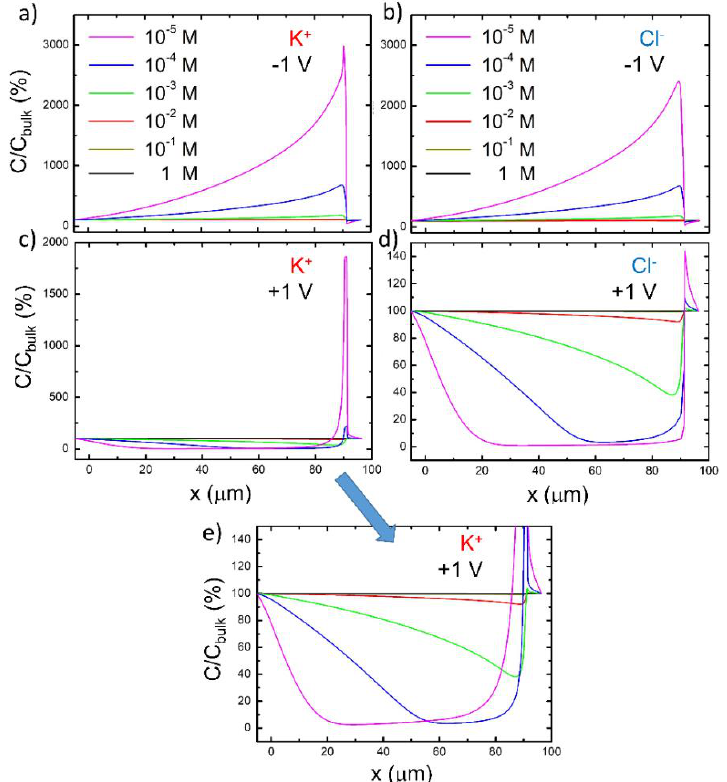
Figure 9. C/C Bulk (%) for K + ( a , c ) and Cl − ( b , d ) along the longitudinal section of the funnel and nanochannel, calculated for different C Bulk with − 1 V ( a , b ) and +1 V ( c , d ) applied between the reservoirs. ( e ) Zoom-in of the graph in ( c ). Note the different scale on the ordinate axis. C Bulk : 1 M (black line), 10 −1 M (dark yellow), 10 −2 M (red), 10 −3 M (green), 10 −4 M (blue), and 10 −5 M (magenta).